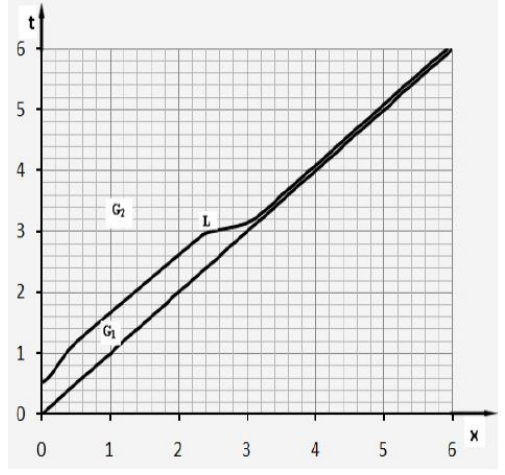
Figure 6: Area G . Graphs of the line L and sets G 1 , G